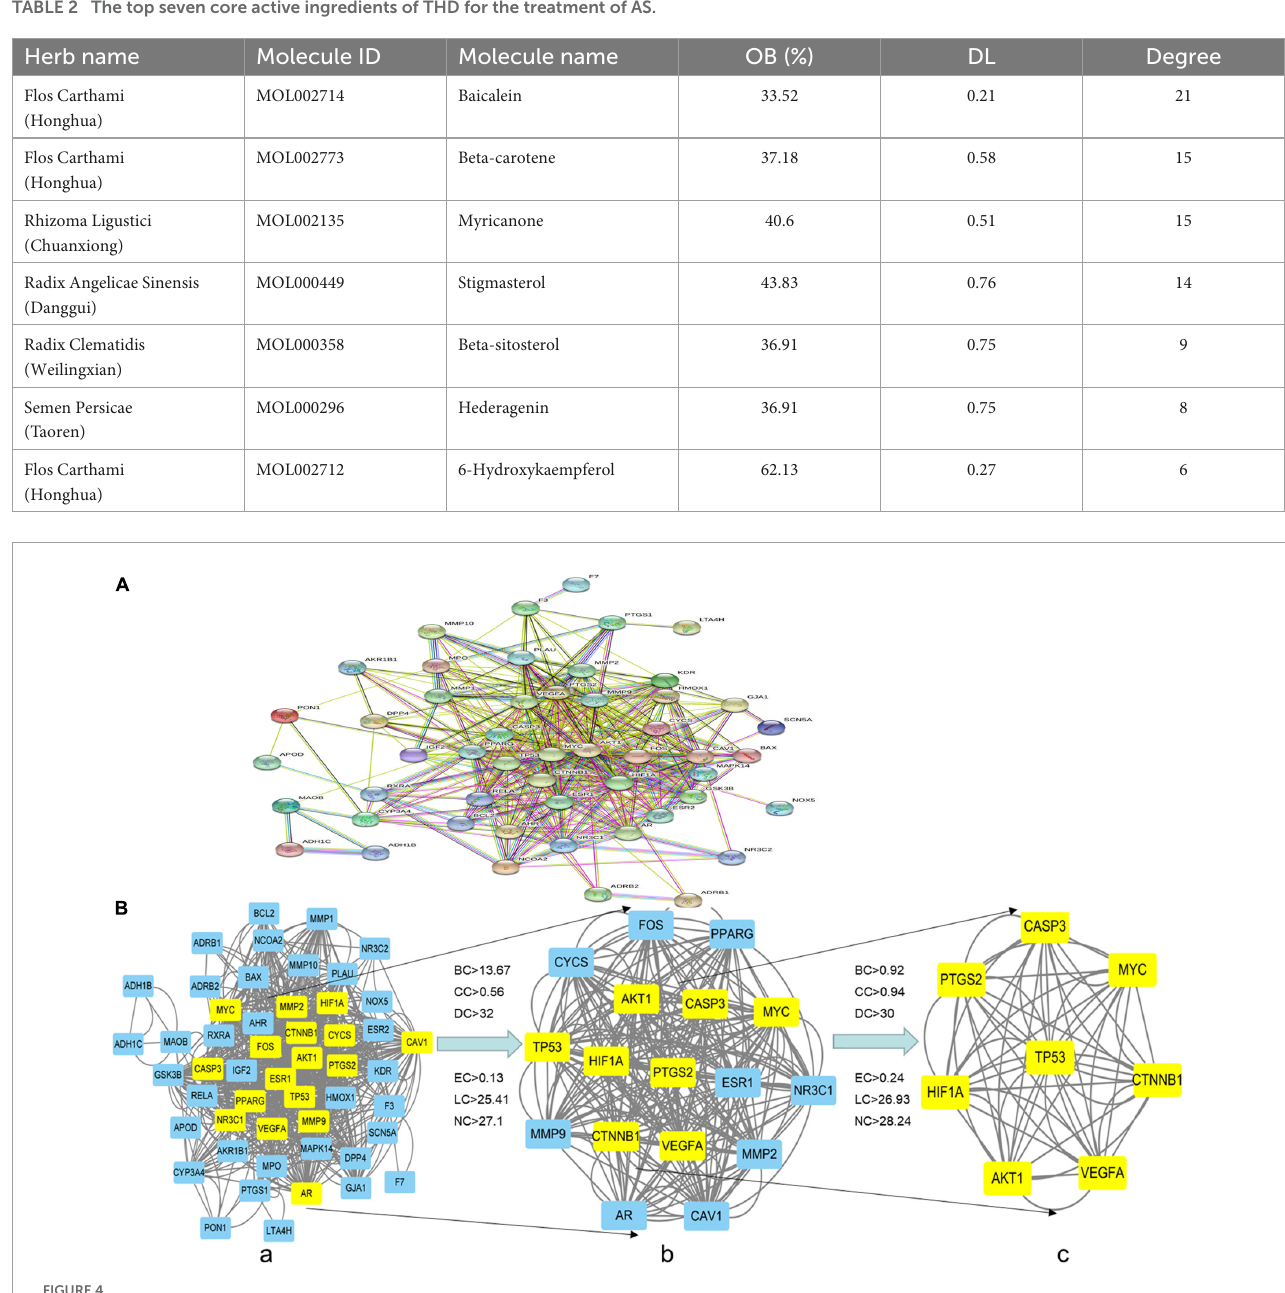
FIGURE4 PPI network of the intersection targets of THD against AS. (A,B) The network topology analysis of the PPI network. (a) PPI network of the intersection targets, with 52 nodes and 834 edges. (b) The subnetwork, after first filtering, comprises 17 nodes and 258 edges. (c) After the second filtration, the core network comprises eight nodes and 56